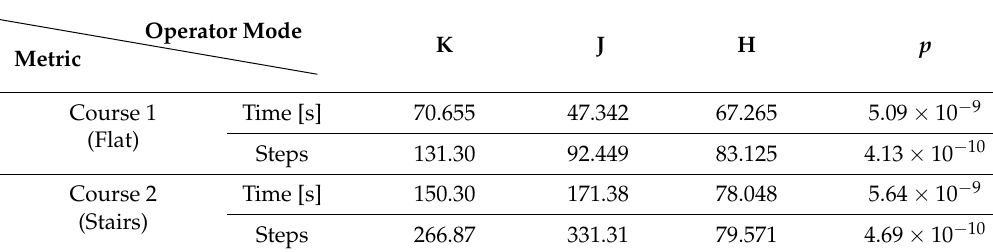
Table 1. Experiment I Mean Time to Completion and Mean Steps.